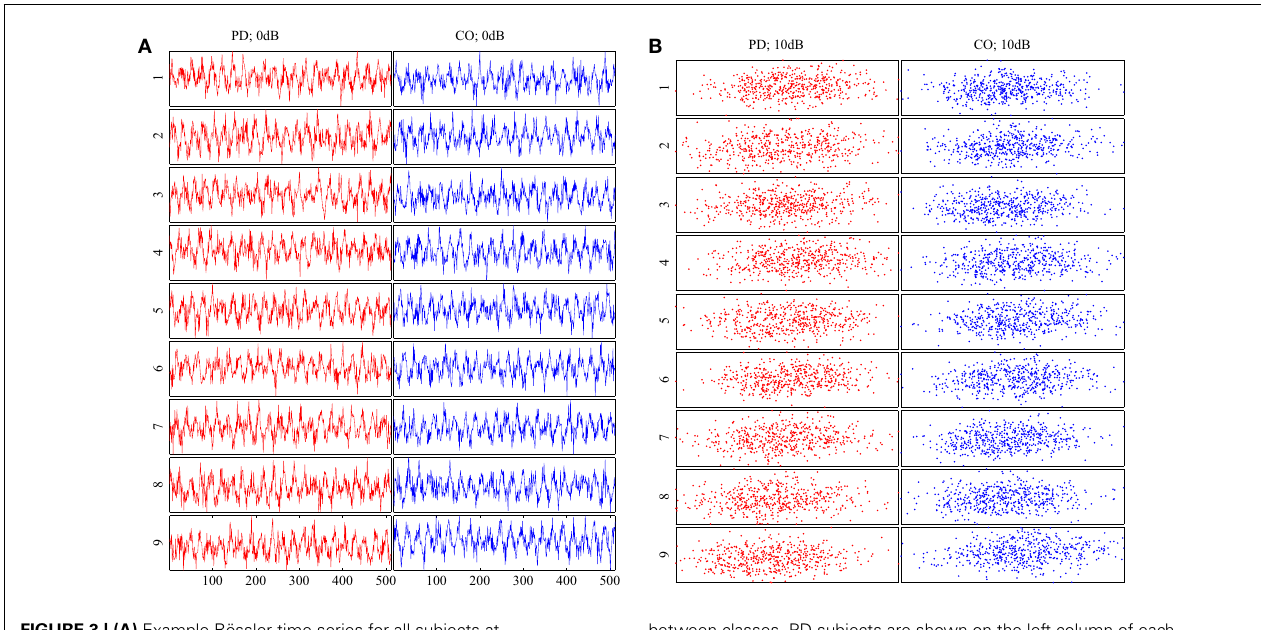
FIGURE 3 | (A) Example Rössler time series for all subjects at SNR = 0dB. (B) Embeddings of the time series in (A) . All time series and embeddings are very similar as there are no patterns that discriminate